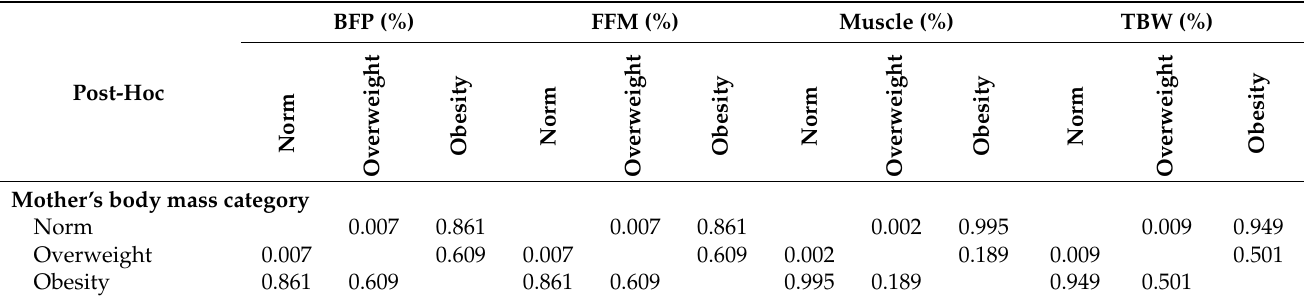
Table 10. The post-hoc test in reference to the difference between the body build parameters in relation to mother’s body mass